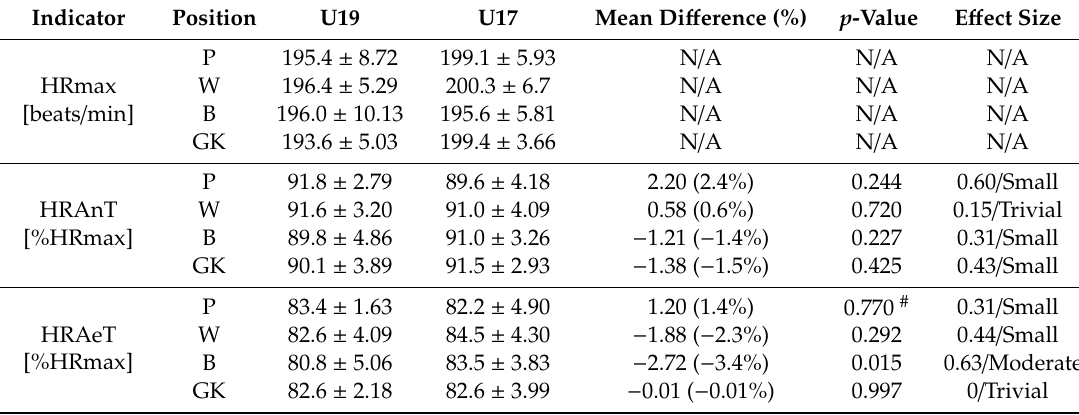
Table 5. Internal load parameters of the subjects.